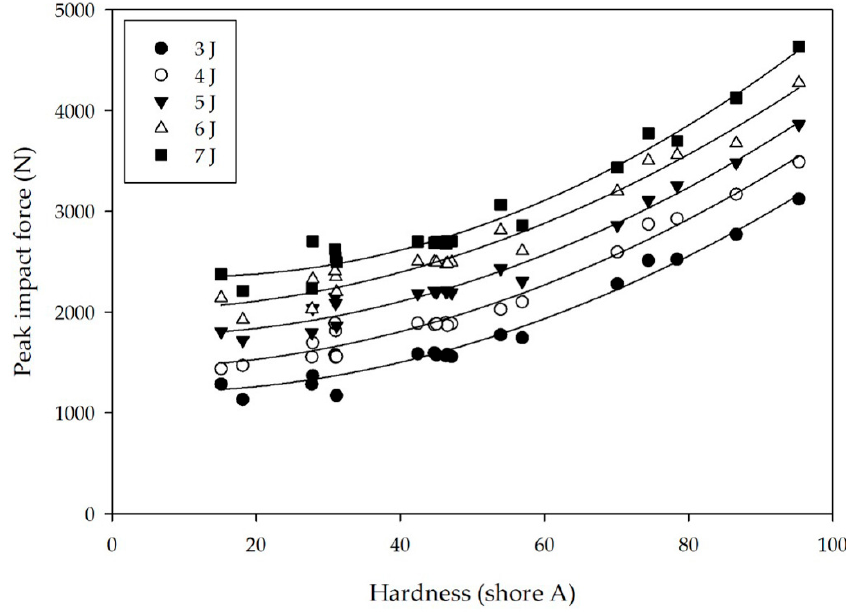
Figure 5. Dependence of peak impact force on natural rubber (NR) hardness evaluated at different energy levels (see legend). Solid lines correspond to quadratic regressions of the data.